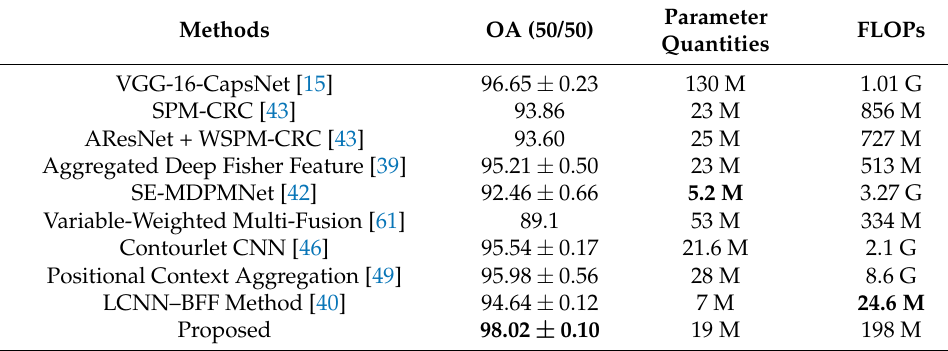
Table 12. Complexity comparison on RSSCN